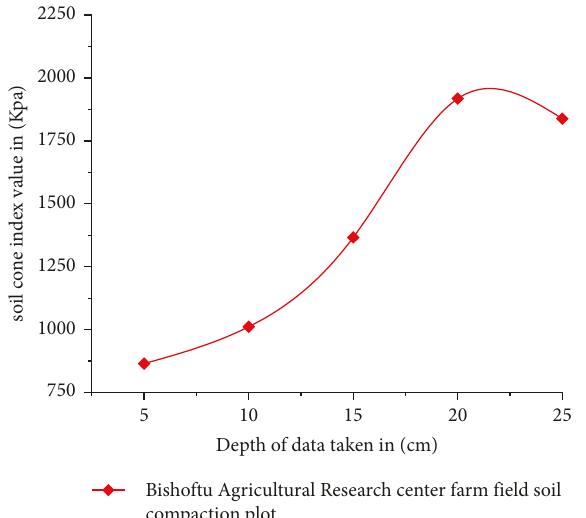
Figure 5: Average value of all sample points soil cone index vs.